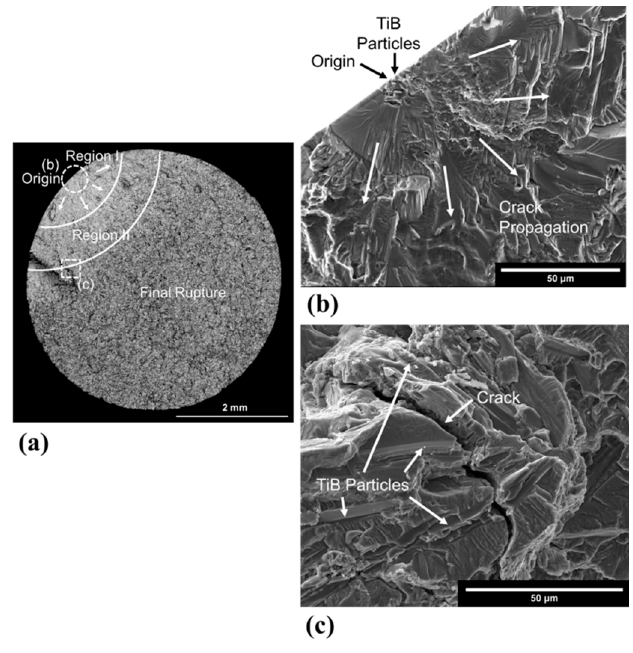
Figure 14. ( a ) BSE-SEM image highlighting the overall fracture surface of a PTA-SFFF Ti–TiB fatigue sample, which was tested at a stress amplitude of 432.5 MPa and failed at 24,600 cycles. ( b ) SE-SEM image highlighting the fatigue crack origin and crack propagation, taken from the enclosed area in Region I highlighted in ( a ). ( c ) SE-SEM image showing a cracked fracture surface with TiB particles, taken from the enclosed area in the Final Rupture region highlighted in ( a ).